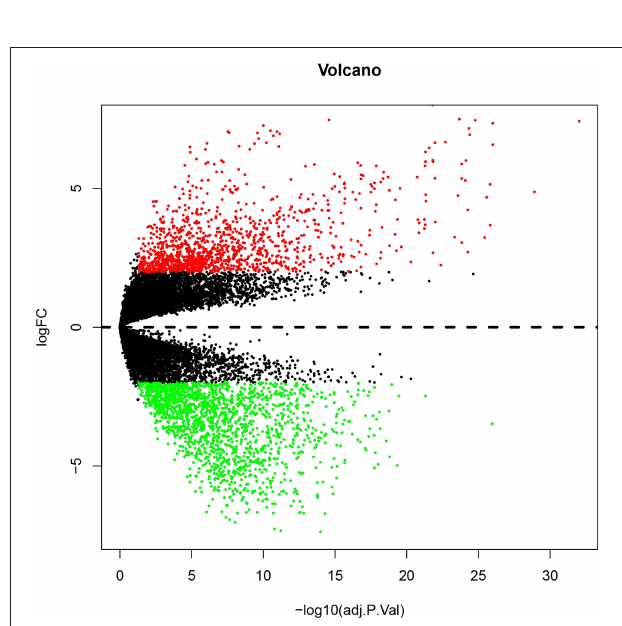
FIGURE 5 | The differentially expressed genes (DEGs) between GBM samples and normal samples from TCGA database. The red and green dots represent significantly upregulated and downregulated DEGs, respectively. The black dots represent genes that are not differentially expressed tumor samples and normal